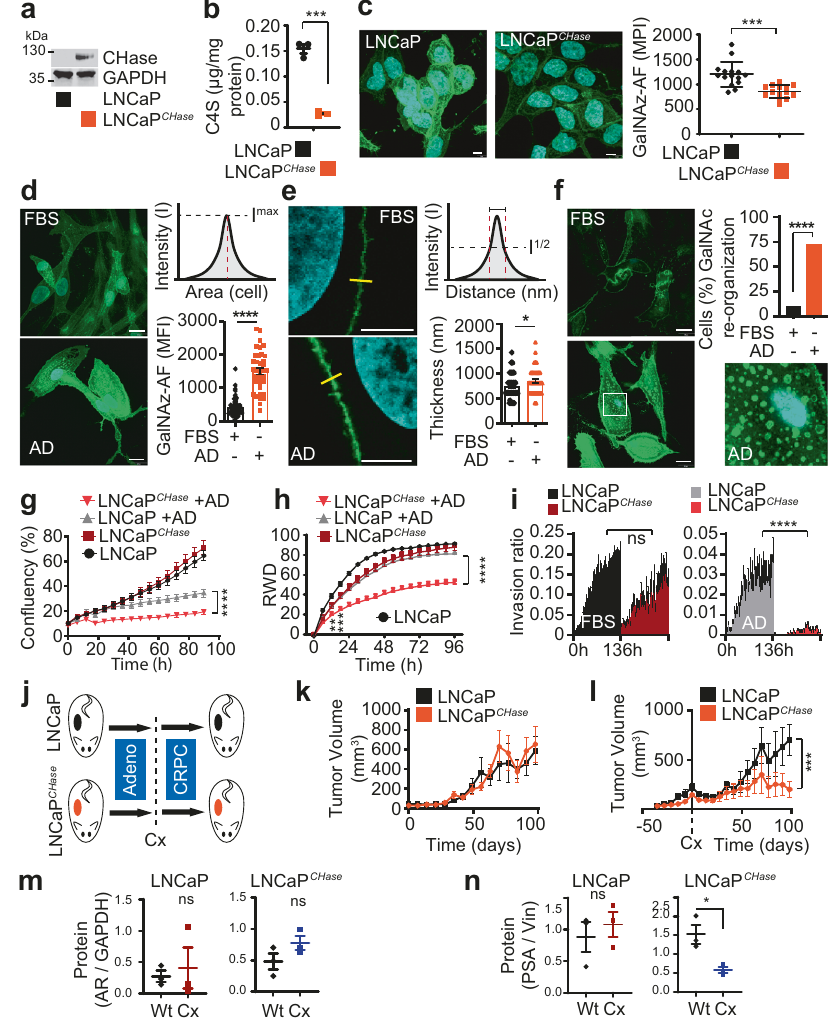
Fig. 5 | Prostate cancer becomes dependent on high chondroitin sulfate levels after ARPI. a Expression of CHase in LNCaP CHase and parental cell lines by western blotting. b C4S quanti fi cation in LNCaP and LNCaP CHase cell lines using LC-MS.